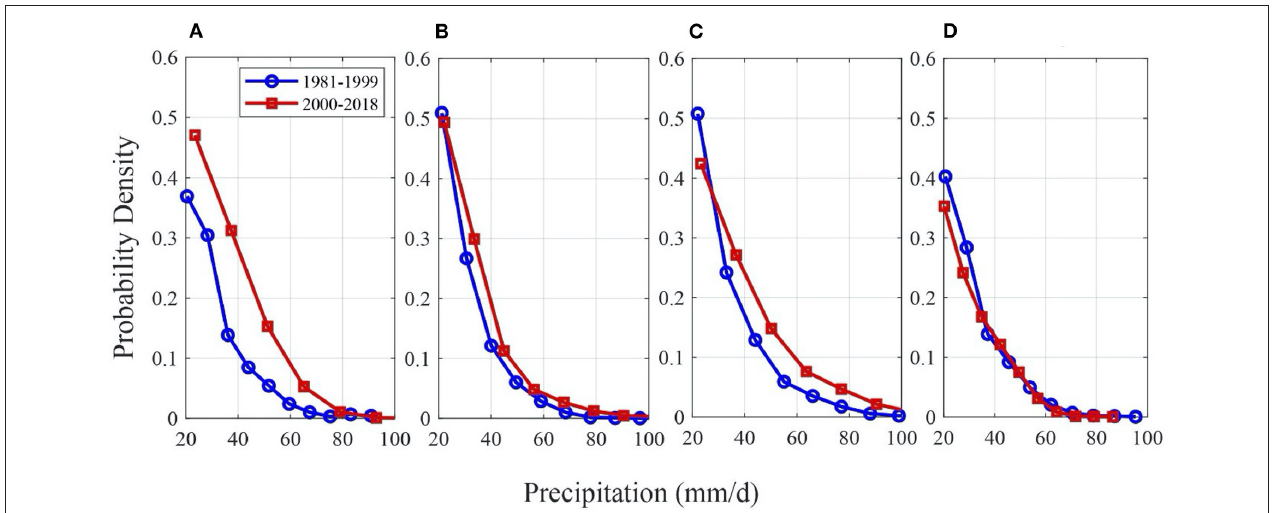
warm colors refer to drying trends. The size of the cross markers shows the three significance levels used to perform a Mann-Kendall test on the Theil-Sen trends. Markers are not shown in grids with non-significant trends.